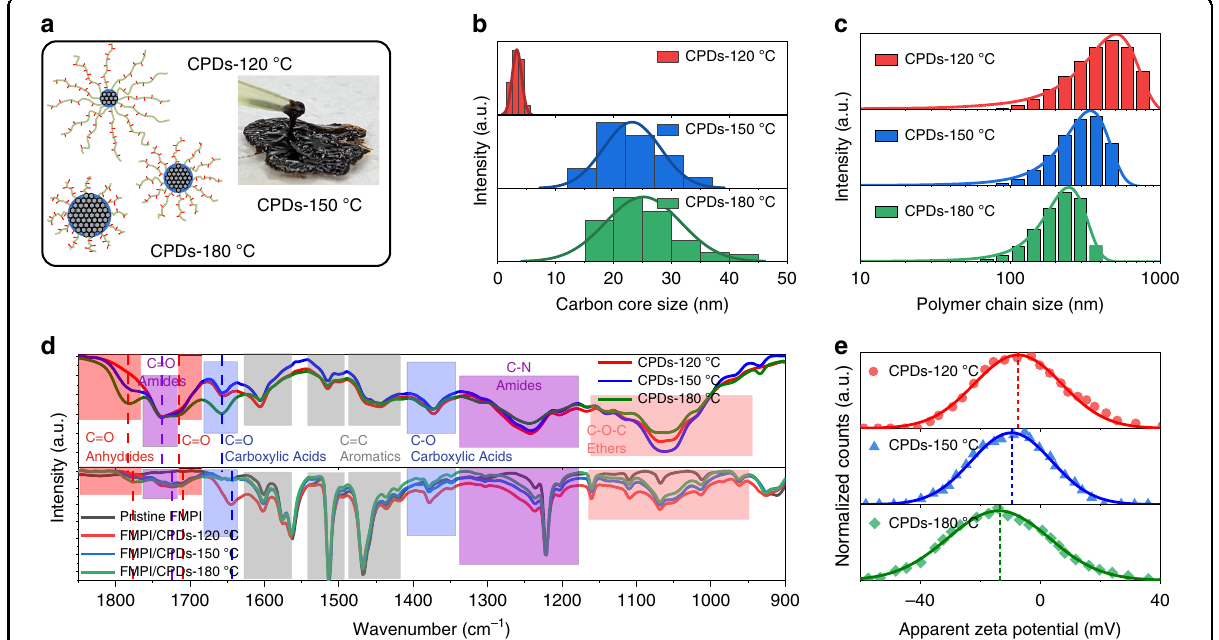
Fig. 1 Morphology and functional group characteristics of CPDs. a The diagram for morphologic properties of various CPDs fabricated under different carbonization temperatures. Insert: photograph of fabricated viscoelastic CPDs. The distributions of the carbon cores ( b ) and polymer chains ( c ) analyzed from TEM and DLS measurements, respectively. d The FTIR spectrum of different CPDs (top) and FMPI/CPDs (bottom). e The zeta potential pattern of three different